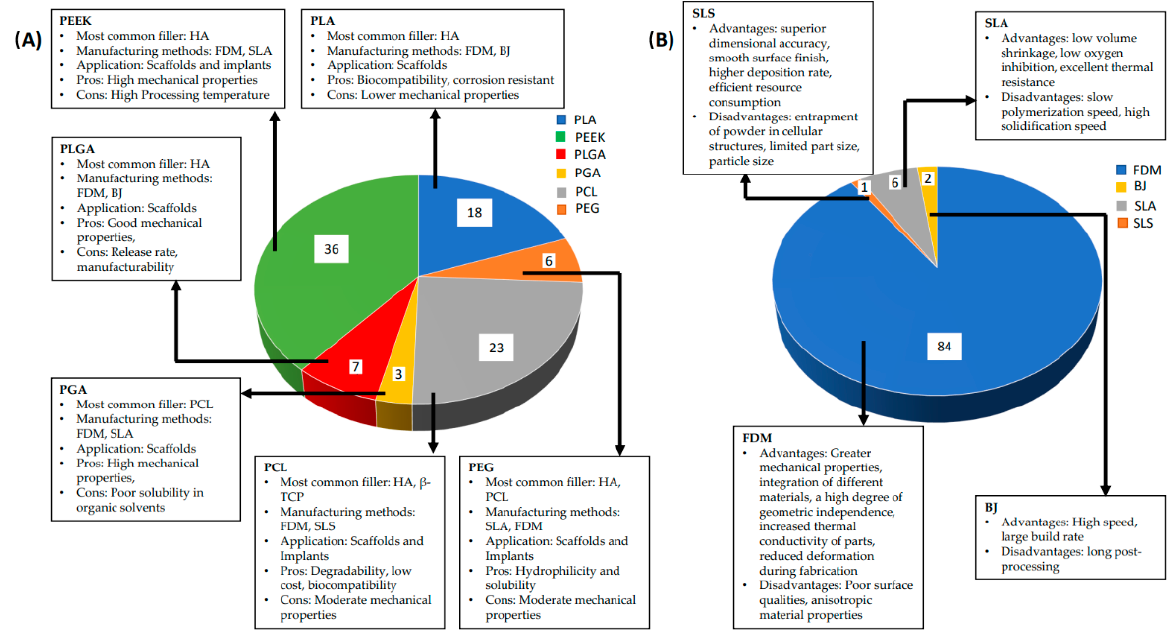
Figure 2. Pie chart. ( A ) Number of studies of each polymer available in the literature. ( B ) Number of times the AM method is used in the literature. (For interpretation of the references to color in this figure legend, the reader is referred to the web version of this article.)